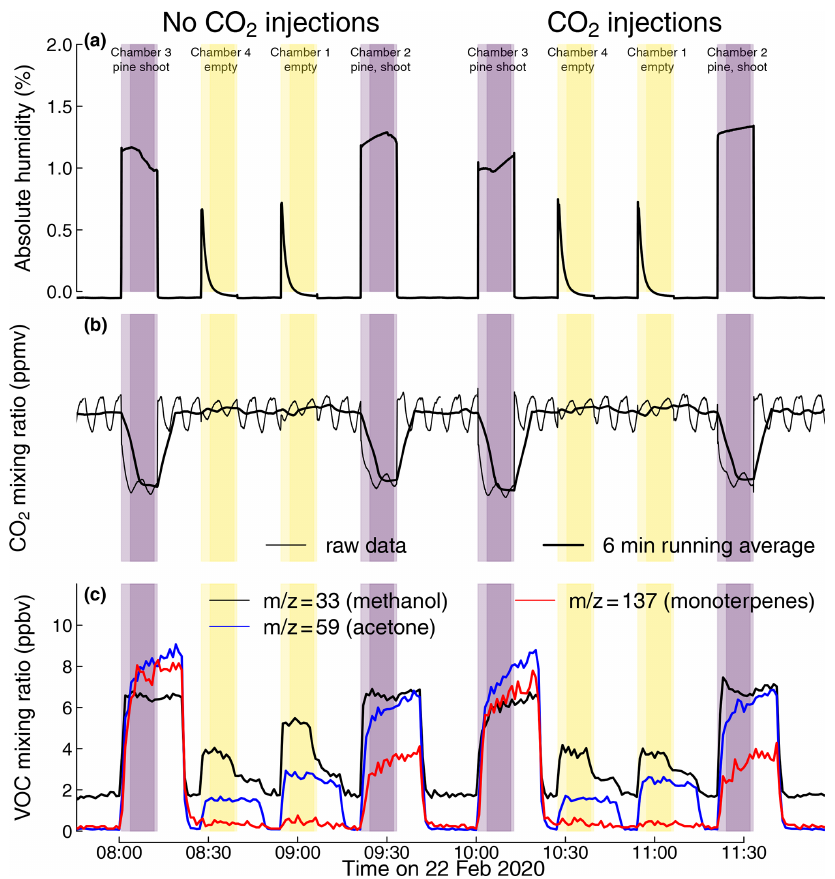
Figure 6. Mixing ratios of water (a) , CO 2 (b) , and volatile organic compounds (c) during dynamic chamber closures of four shoot chambers in the greenhouse system. Chambers 2 and 3 each contained a shoot of a 2-year-old pine sapling; chambers 1 and 4 were kept empty as blank controls. Black lines represent the measured mixing ratios of water (a) and CO 2 (b) . In panel (b) , the thin black line represents the raw measured CO 2 mixing ratio, while the thick black line represents its 6min running average, calculated to compensate for an oscillation in the analyser signal. Shaded areas indicate periods when chamber air was analysed, with darker colours indicating time periods used to calculate C out ; non-shaded areas indicate periods when the ingoing air was measured bypassing the chamber. The depicted data were measured on